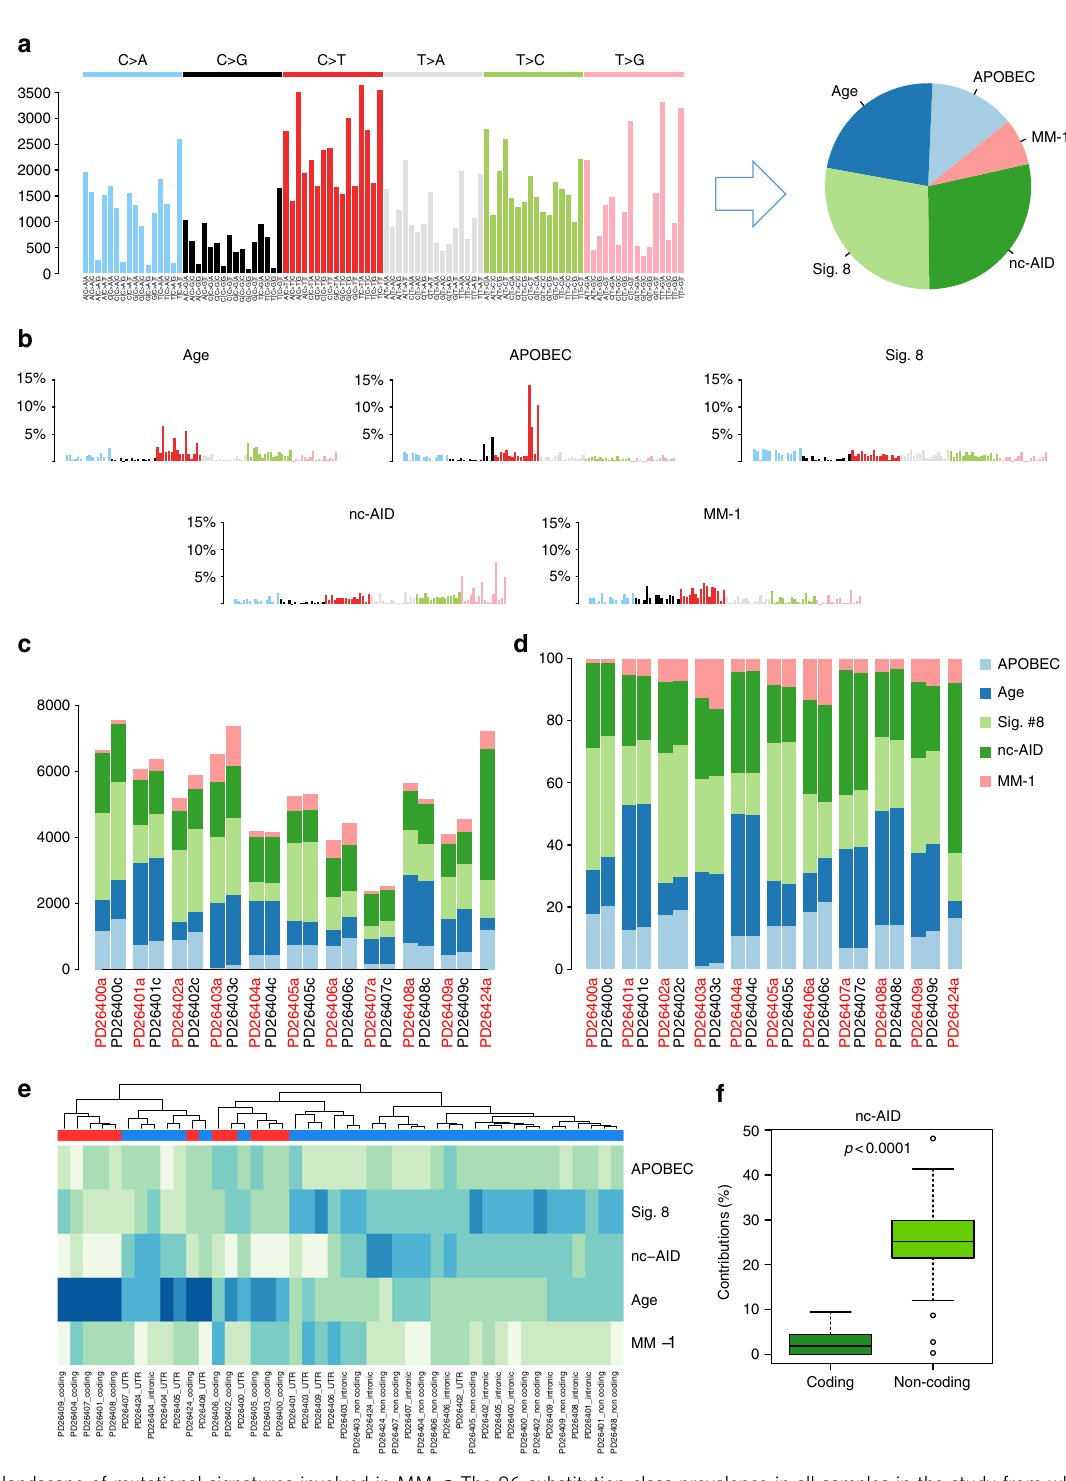
Fig. 4 The landscape of mutational signatures involved in MM. a The 96-substitution class prevalence in all samples in the study from which NNMF extracted fi ve main processes. b Representation of the fi ve processes extracted by NNMF. c , d Barplots representing the absolute ( c ) and the relative ( d ) contribution of each mutational signature for each sample. e Hierarchical clustering based on the relative contribution of each mutational signature in each patient, according to the coding or noncoding status of each mutation. f Boxplot showing a strong association between nc-AID process and noncoding mutations. The p value was extracted by Wilcoxon test ( wilcox.test R function). The whiskers are proportional to the interquartile range and are plotted with default parameters using the boxplot.stats R